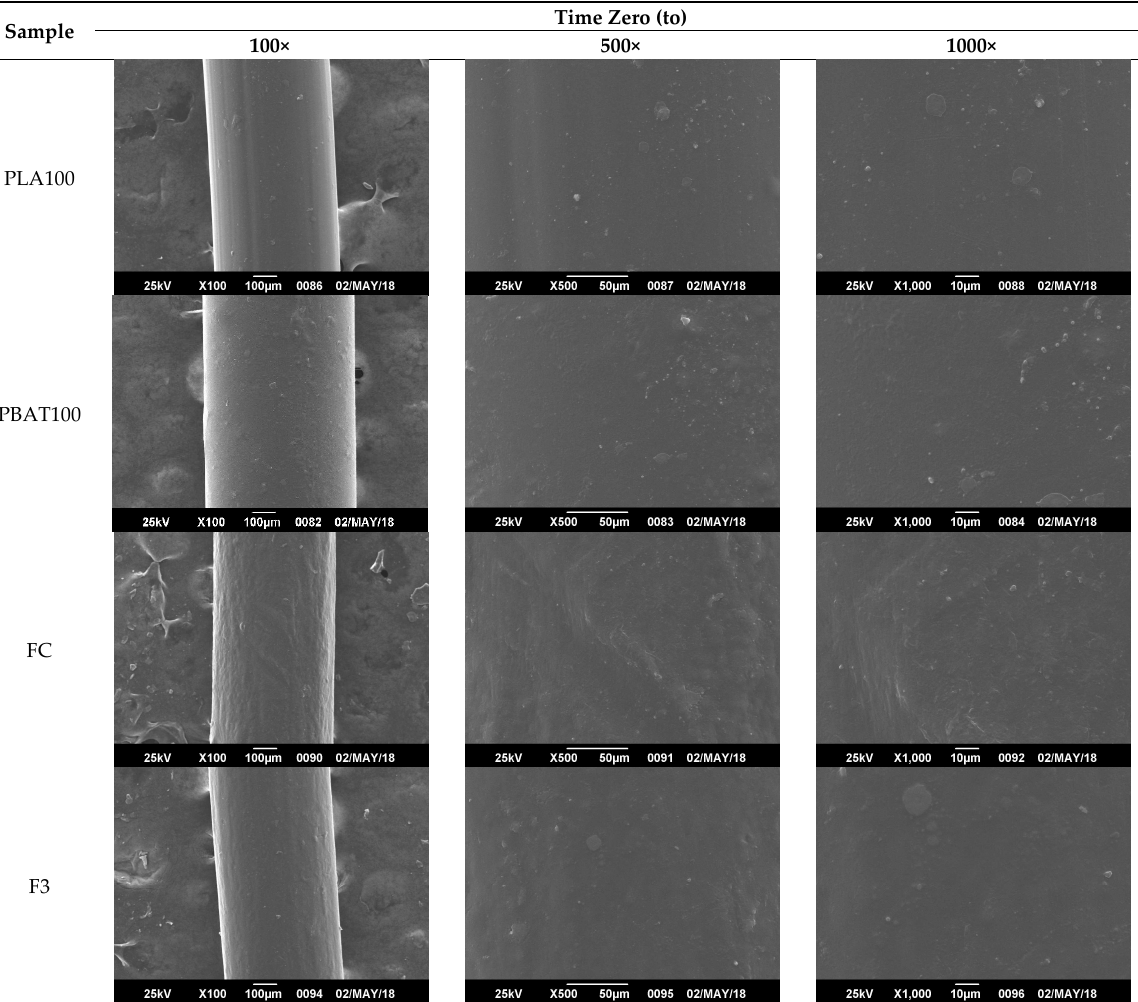
Figure 11. SEM micrographs of fibers’ surface morphology of the non-degraded fibers. Time zero ( t o ).